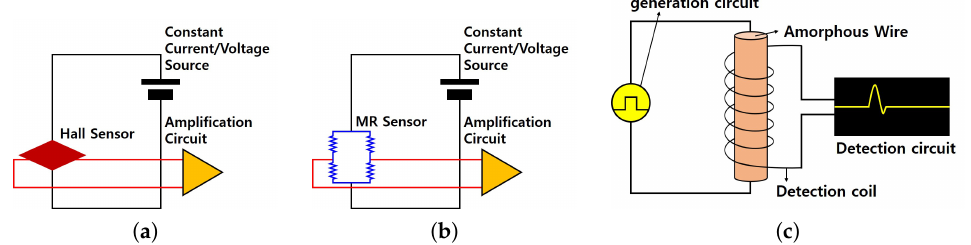
Figure 1. Representative magnetic sensors. ( a ) is the hall sensor and ( b ) is the MR sensor, ( c ) is the MI